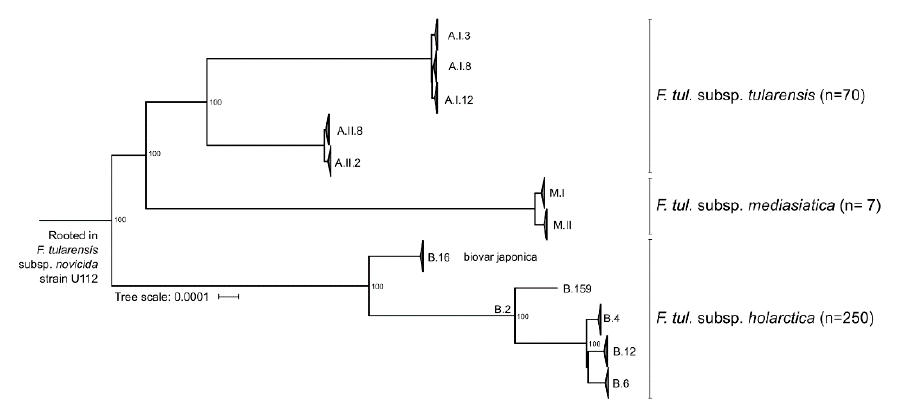
Figure 3. Phylogenetic tree of F. tularensis visualizing subspecies and major genetic subgroups.